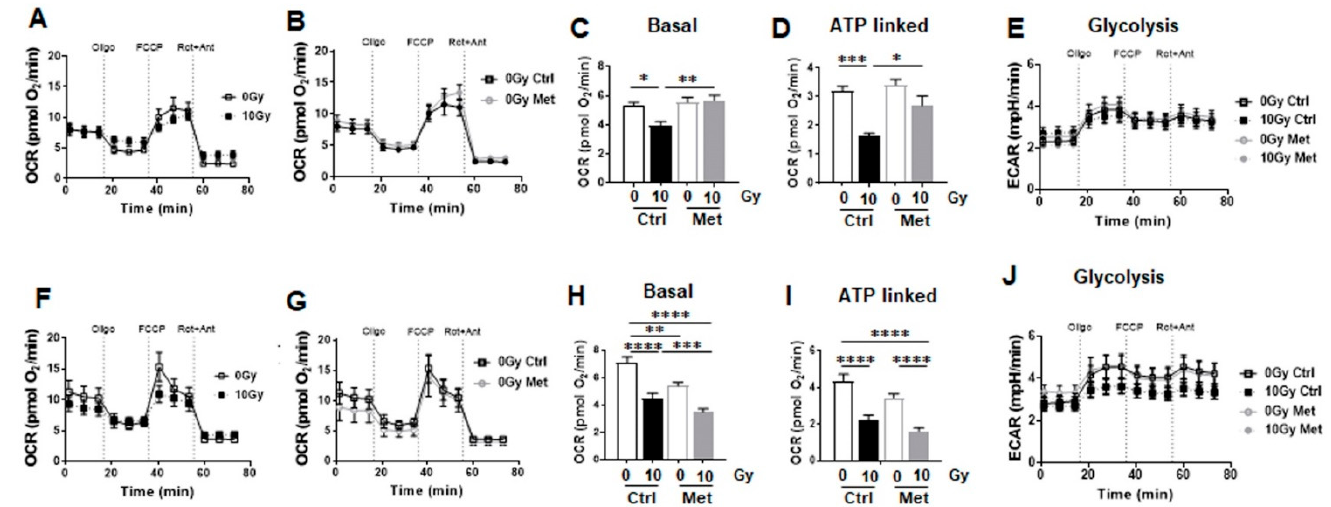
Figure 9. Metformin treatment does not impact on mitochondrial respiration in NSCLC, nor in combination with RT. Extracellular flux analyses following (24 h after) metformin and RT treatment were performed in order to measure oxygen consumption rates (OCR) and extracellular acidification rates (ECAR) in NCI-H460 ( A – E ) and A549 ( F – K ) over time, while oligomycin (Oligo; 1 µM), FCCP (2 µM) and rotenone/ Antimycin A (Rot/Ant; 0.5 µM) were added at indicated time points. ( A , F ) OCR levels of control and irradiated malignant epithelial cells are shown. ( B , G ) OCR levels of control and metformin treated malignant epithelial cells are shown. ( C , H ) Basal respiration and ( D , I ) ATP-liked respiration were depicted in separate bar diagrams. ( E , K ) Respective ECAR measurement over time are shown. Data are summarized as mean values ±SEM of 3 independent measured in 4–7 replicates each. p -values indicate: * p ≤ 0.05 ** p ≤ 0.01, *** p ≤ 0.001, **** p ≤ 0.0001 by one-way ANOVA with Tukey’s multiple comparison test.